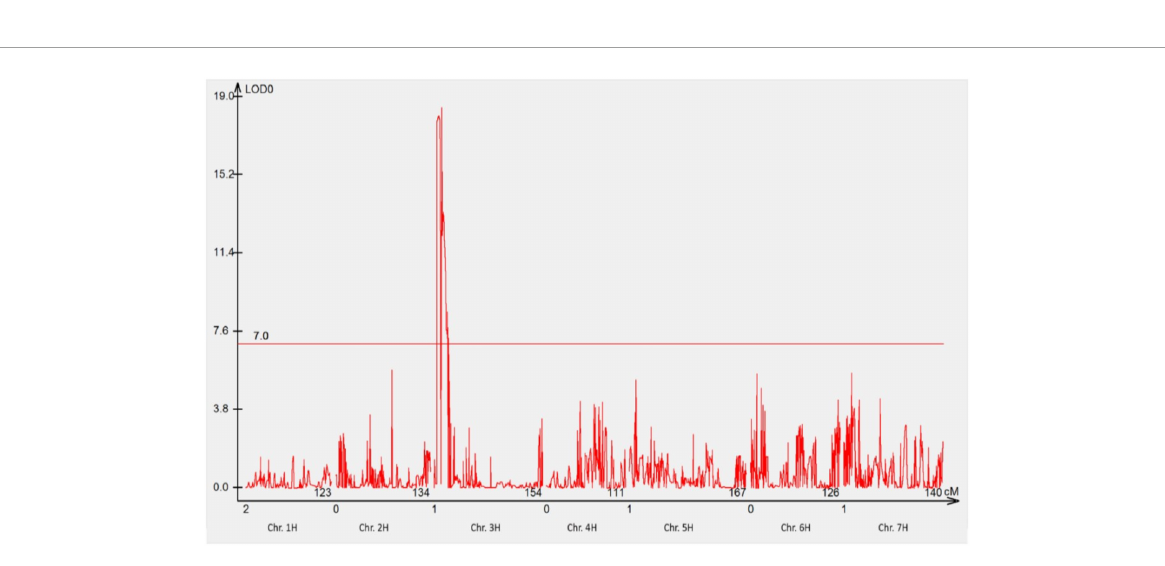
FIGURE3 The most significant QTL conferring resistance to pathotype 5457 P+ detected using genotypic data of DArTseq SNP markers. One QTL was detected on the distal region of the short arm of chromosome 3H. The threshold value was set at 7.0.